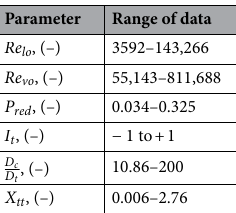
Table 5. The range of non-dimensional parameters used for modeling of FPD.